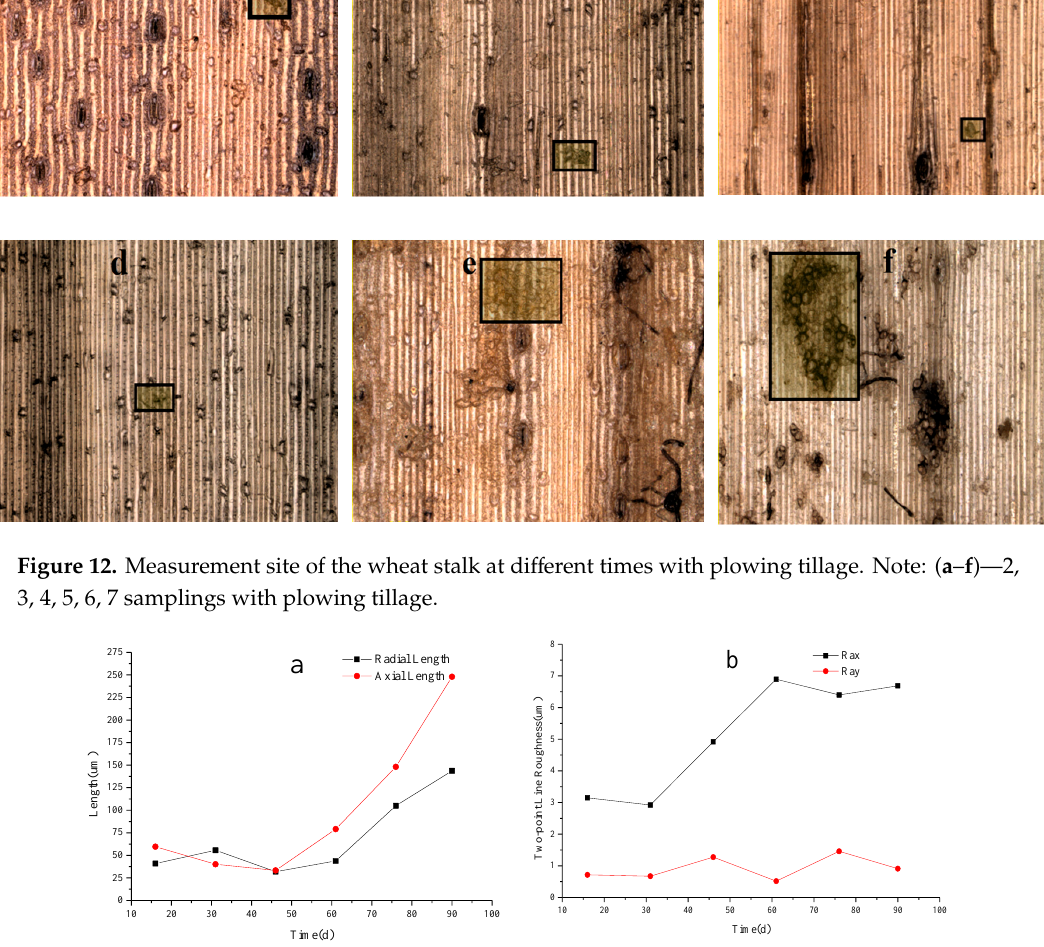
Figure 13. Micro-structure of the wheat stalk over time with plowing tillage. Note: ( a ) Changing of radial and axial length over time with plowing tillage, ( b ) Changing of R ax and R ay over time with plowing tillage.